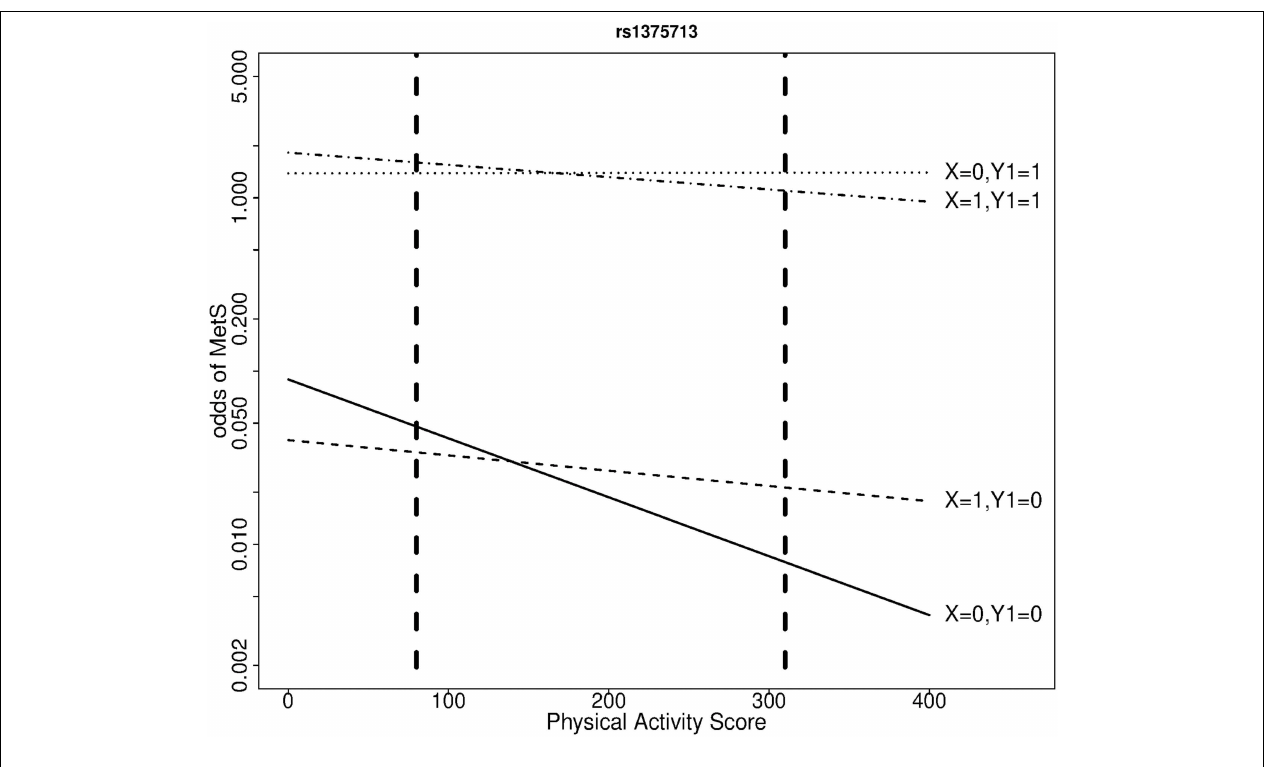
X: number of rs1375713 A alleles. Y 1 = 1 if abdominal obesity, 0 otherwise. Dashed vertical lines show the first and third quartiles of the physical activity